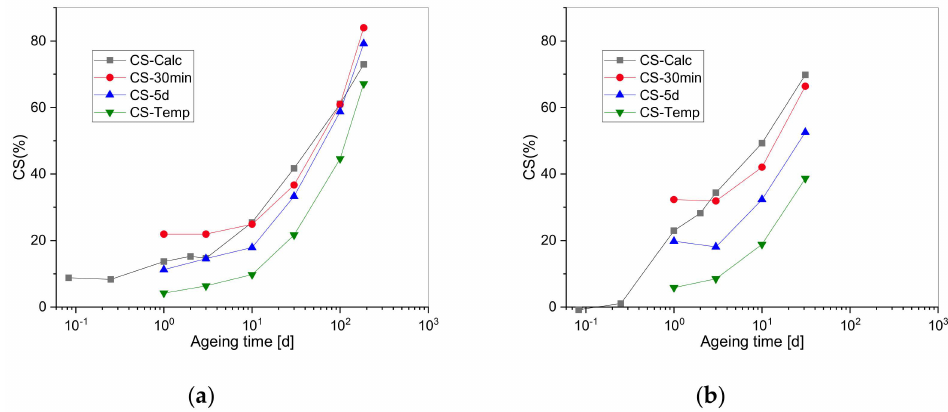
Figure 6. Compression set ( CS )( % ) after ageing at 125 ◦ C versus ageing time for: ( a ) EPDM; ( b )